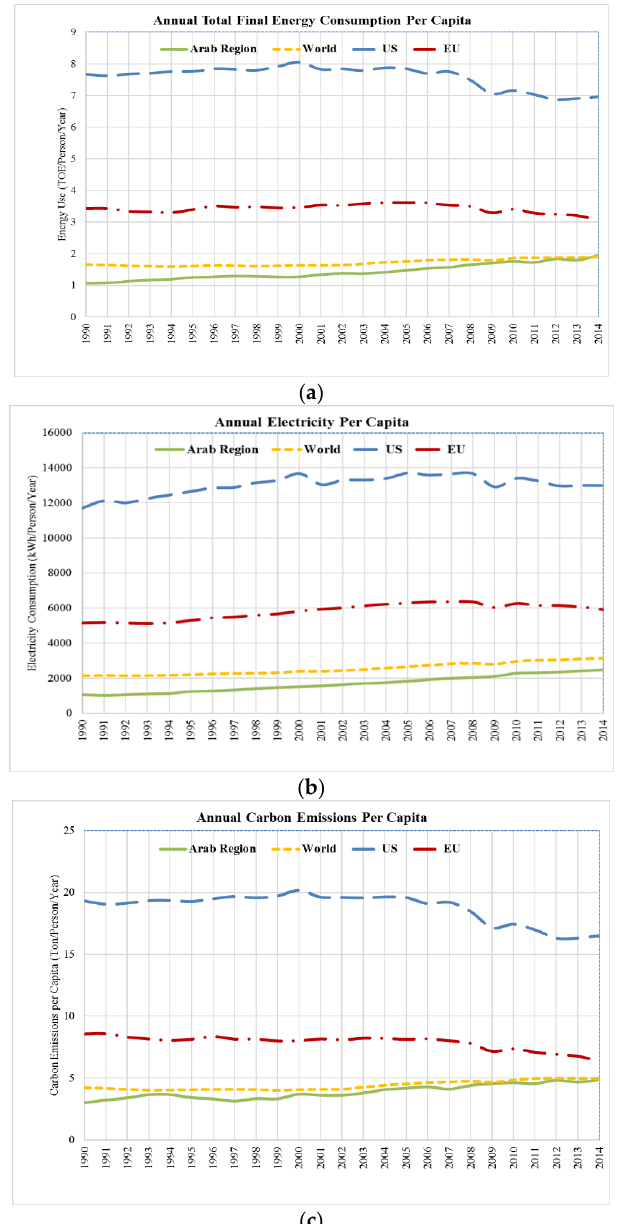
Figure 4. Annual per capita ( a ) final energy consumption ( b ) electricity use, and ( c ) carbon emissions in Arab region compared to averages for EU, US, and the World for the period 1990–2014 (Source of the data: World Bank